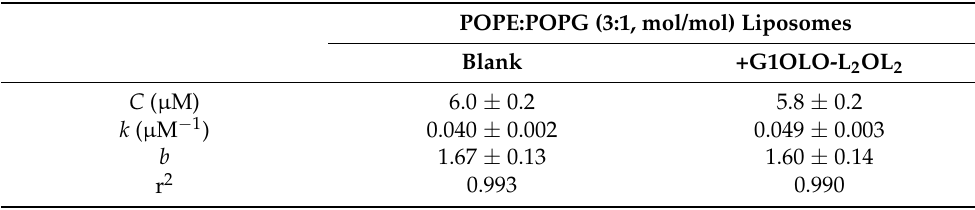
Table 3. Values of the experimental parameters based on the ANS binding data using Equation